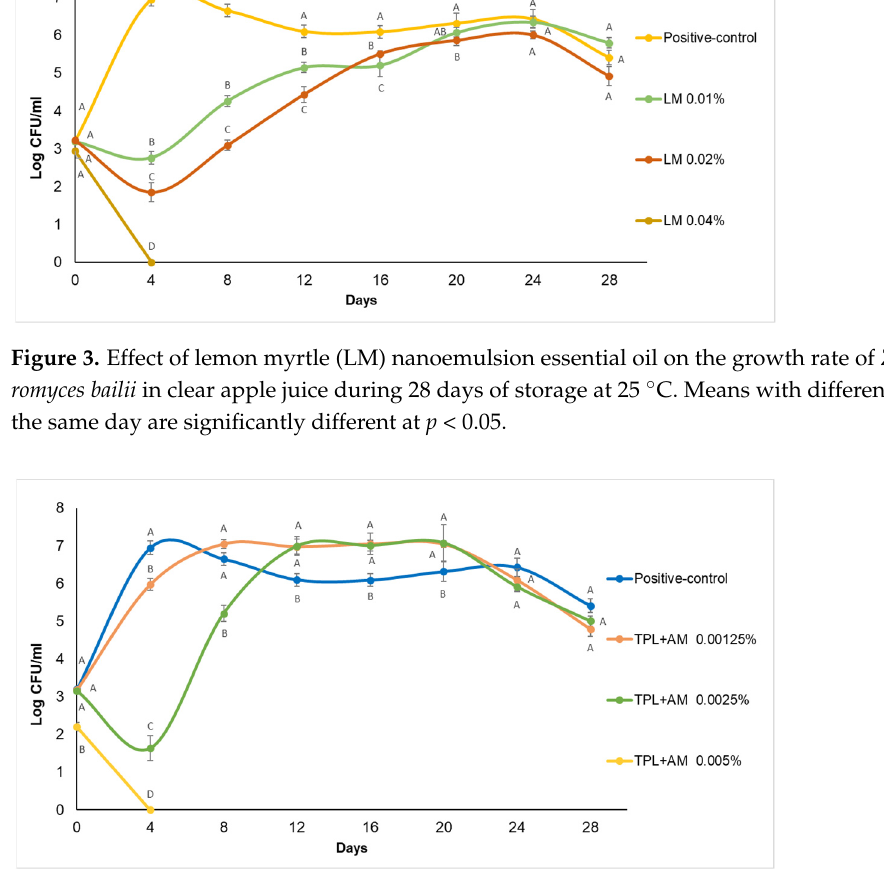
Figure 4. Effect of combining anise myrtle (AM) with Tasmanian pepper leaf (TPL) nanoemulsion essential oil on the growth rate of Zygosaccharomyces bailii in clear apple juice during 28 days of storage at 25 °C. Means with different letters on the same day are significantly different at p < 0.05.